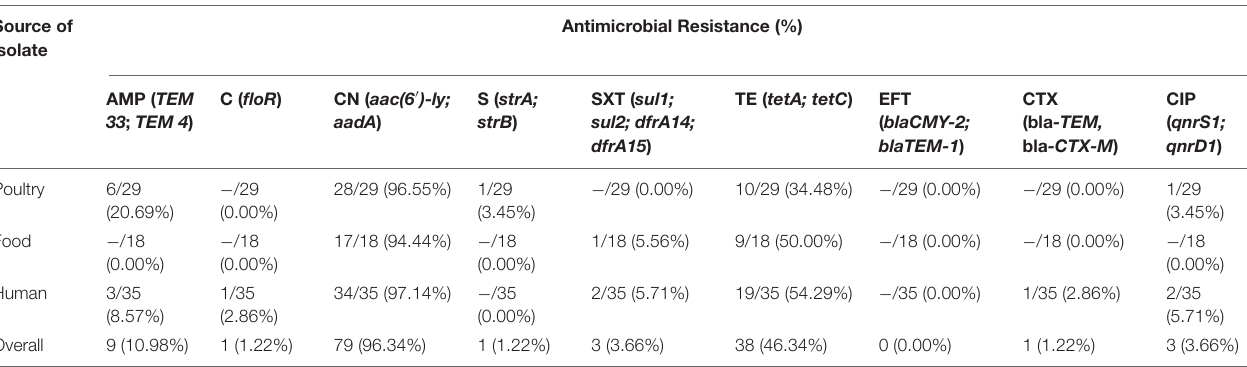
The antimicrobial susceptibility/resistance was determined based zone of inhibition according to the CLSI standard. Ampicillin (AMP), chloramphenicol (C), gentamicin (C.N.), streptomycin (S), sulfamethazine/trimethoprim (SXT), tetracycline (T.E.), ceftiofur (EFT), cefotaxime (CTX), and ciprofloxacin (CIP). TABLE 2 | Distribution of genotypic AMR genes among S . Enteritidis